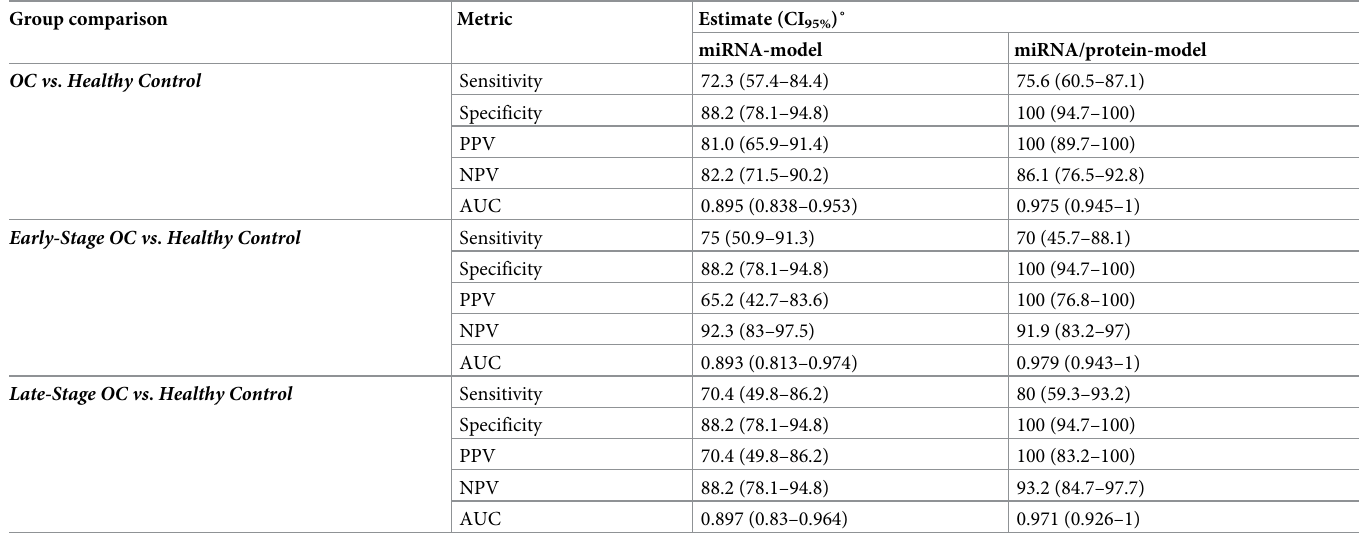
Table 3. Classification performance of the miRNA and miRNA/protein-based models in distinguishing cancer from control patients in the Training Set. Group comparison